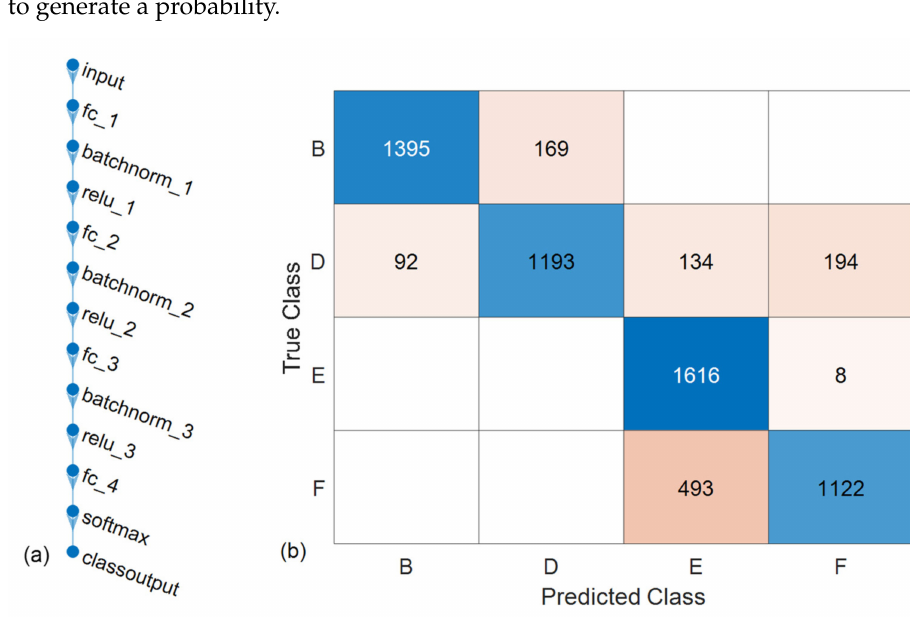
Figure 14. Mode Shape Classifier: ( a ) ANN Architecture; ( b ) Confusion